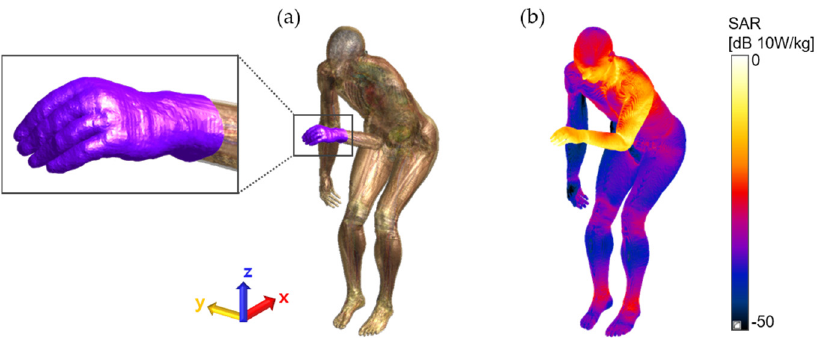
Figure 5. ( a ) Wearing latex glove to reduce the 10 ‐ g averaged SAR. ( b ) 63.7% of 10 ‐ g averaged SAR, in comparison to the maximum 10 ‐ g averaged SAR, was observed (see Table 2, Pose 3 of patient assistant).